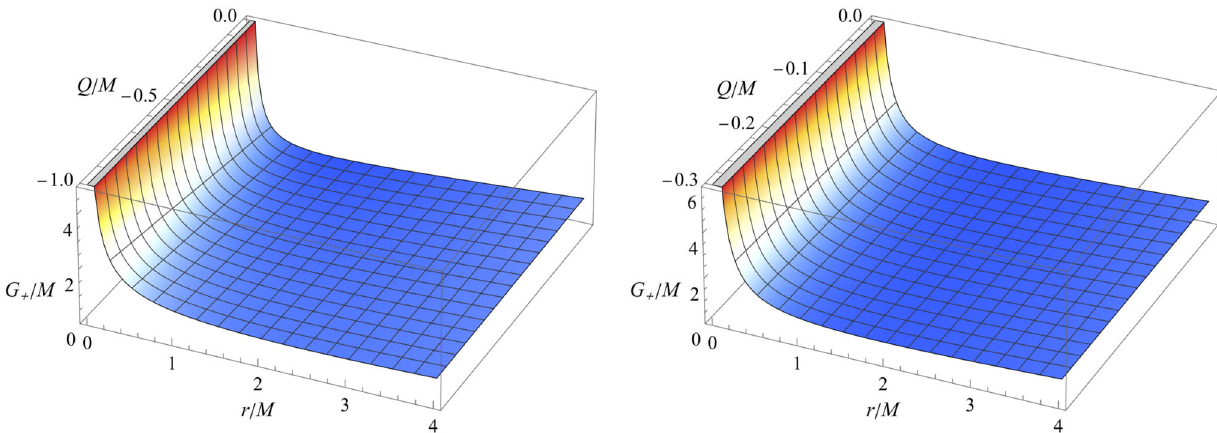
Fig. 7 Plots of G + vs radius r + and hair Q for a = 0 . 6 M and a = 0 . 9